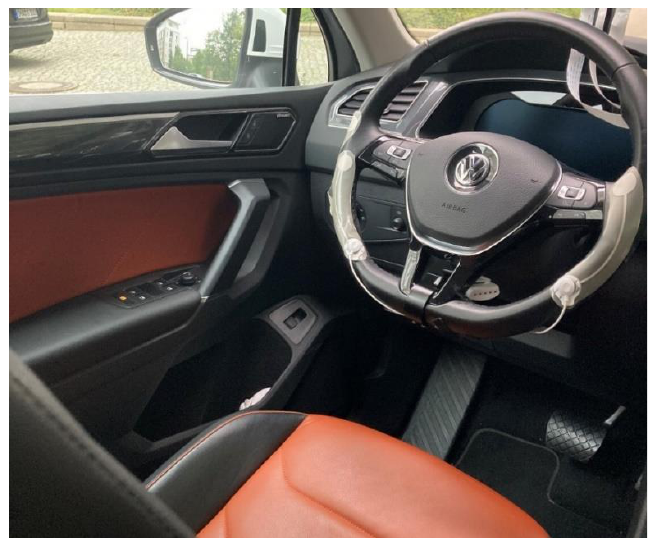
Figure 2. Recording system with the ECG electrodes in the research car.